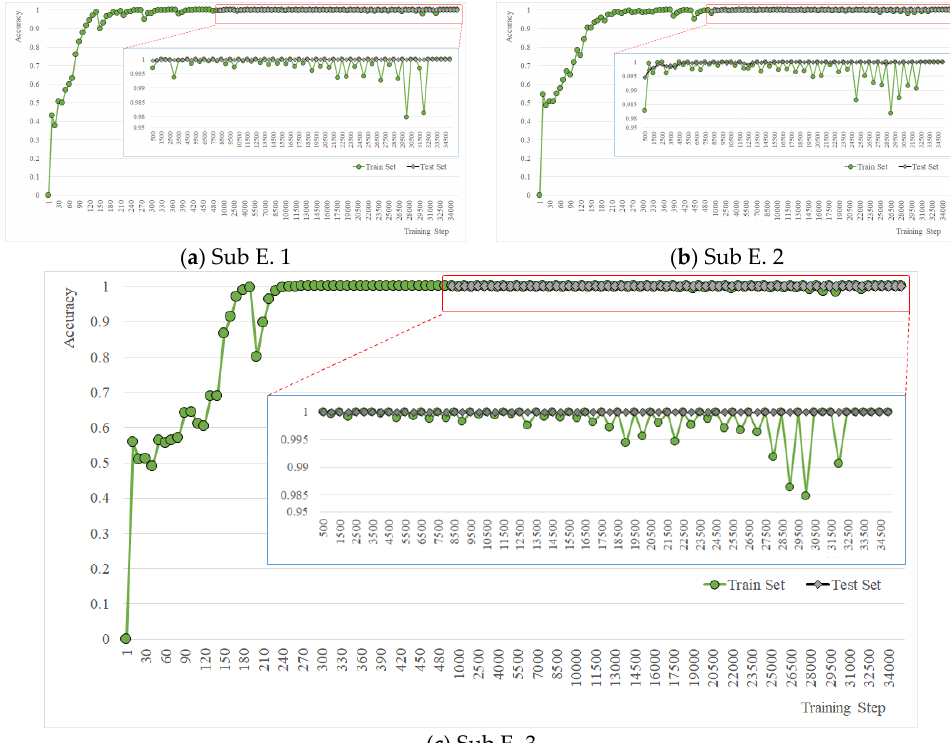
Figure 14. Accuracy of experiment 1 (two-class).